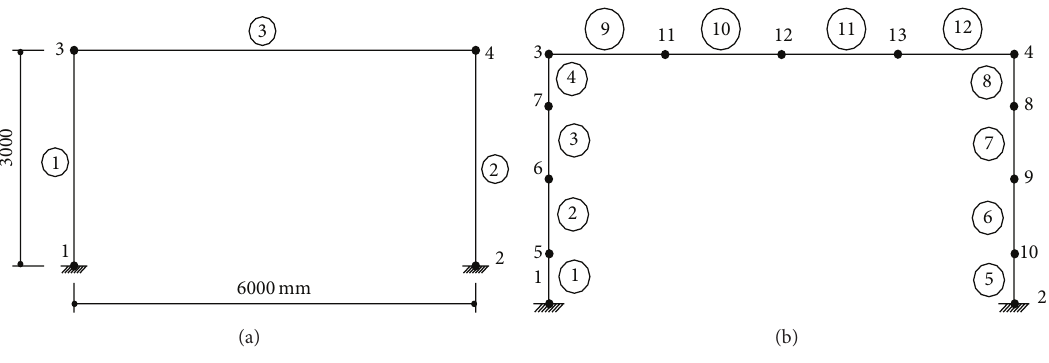
Figure 6: Finite element mesh for (a) FEBA and (b) FEA.